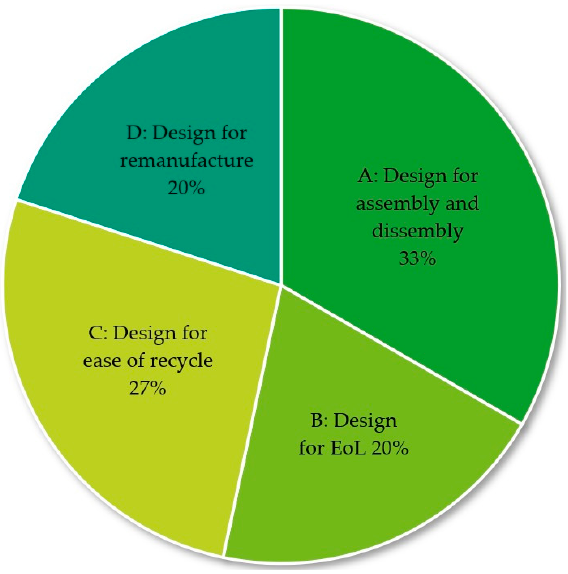
Figure 3. Frequency chart showing approaches of reviewed articles. Table 2. The main article’s themes, based on the results of the articles listed in Table 1. The Main Focus of Articles Listed in Table 1. No.